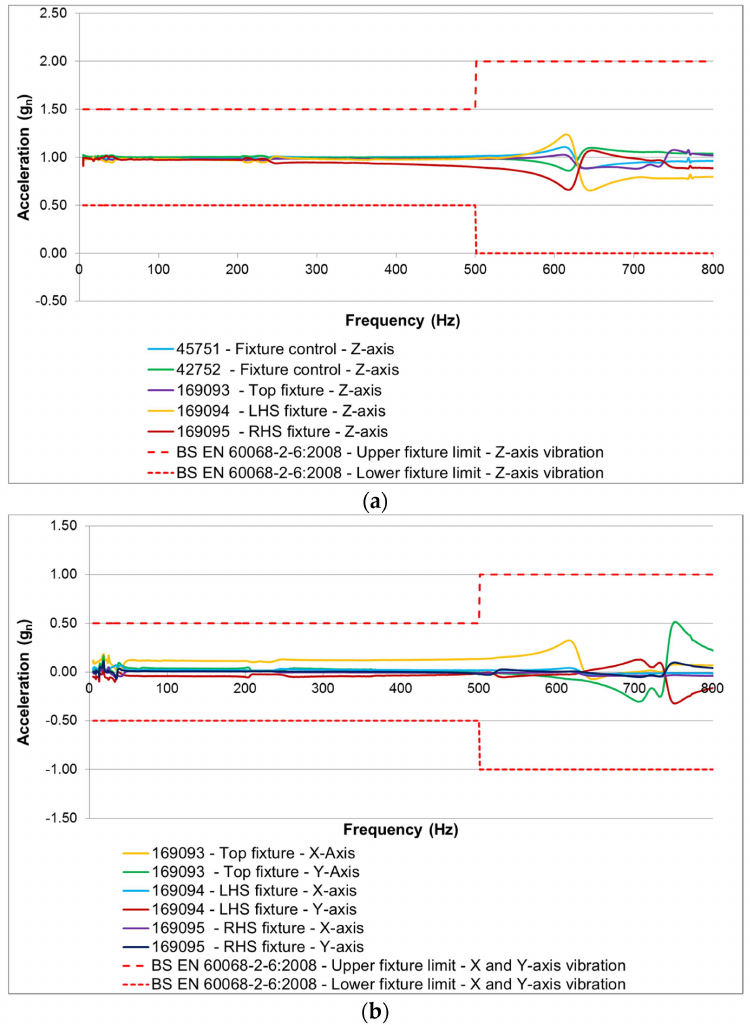
Figure 3. BS EN 60,068 resonance evaluation of 18,650 durability fixture: ( a ) Z-Axis of fixture ( b ) X and Y-Axis of